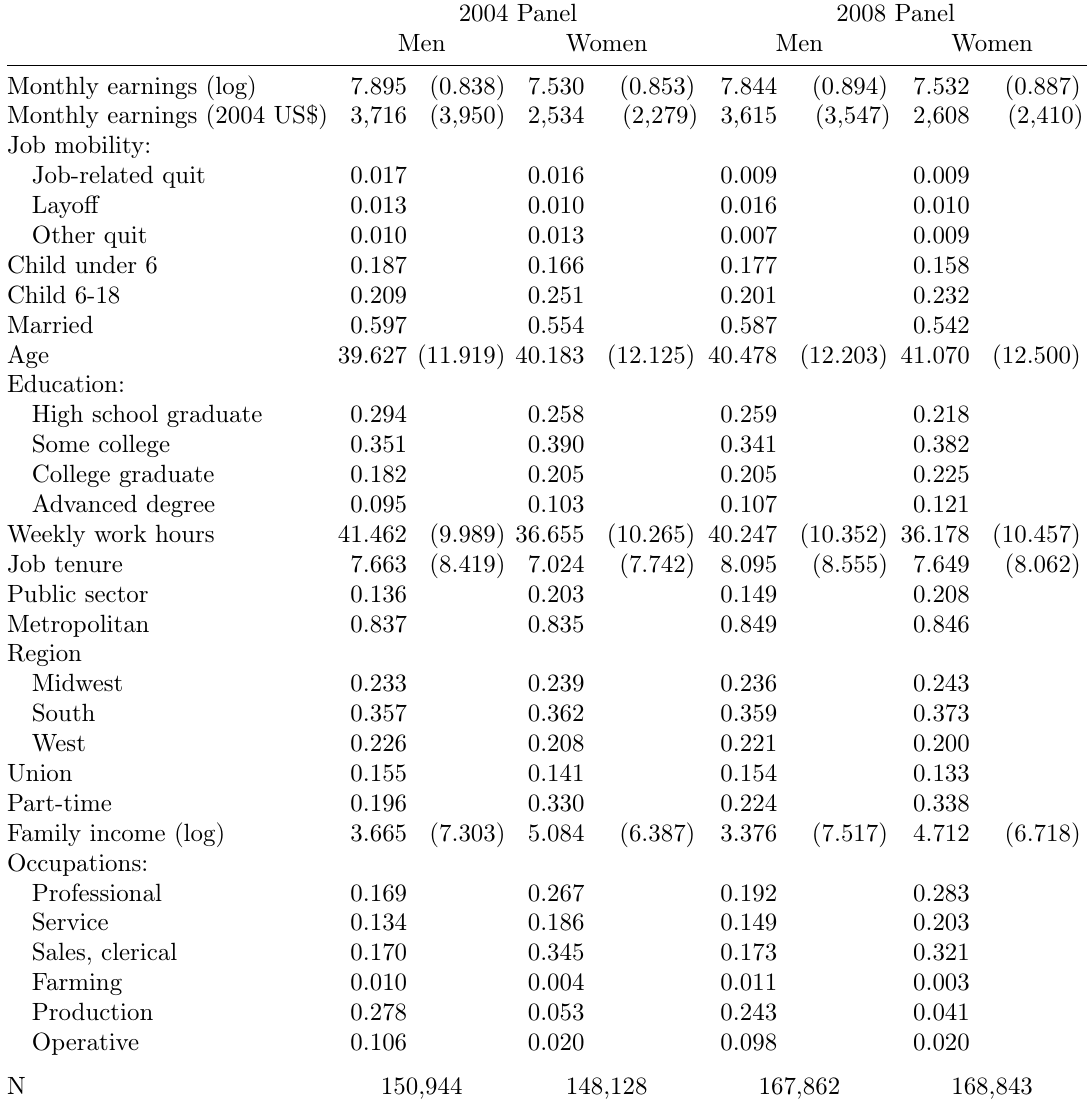
Table 1: Means and standard deviations (in parentheses) for the variables used in the